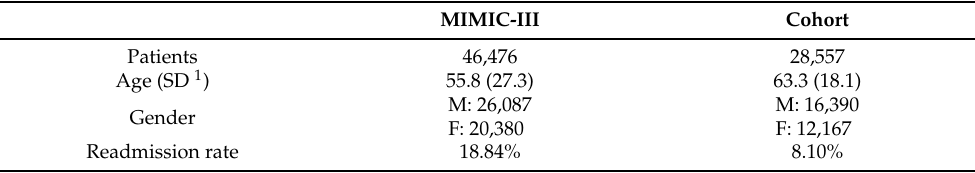
Table 1. Patient characteristics for the selected dataset and for the original